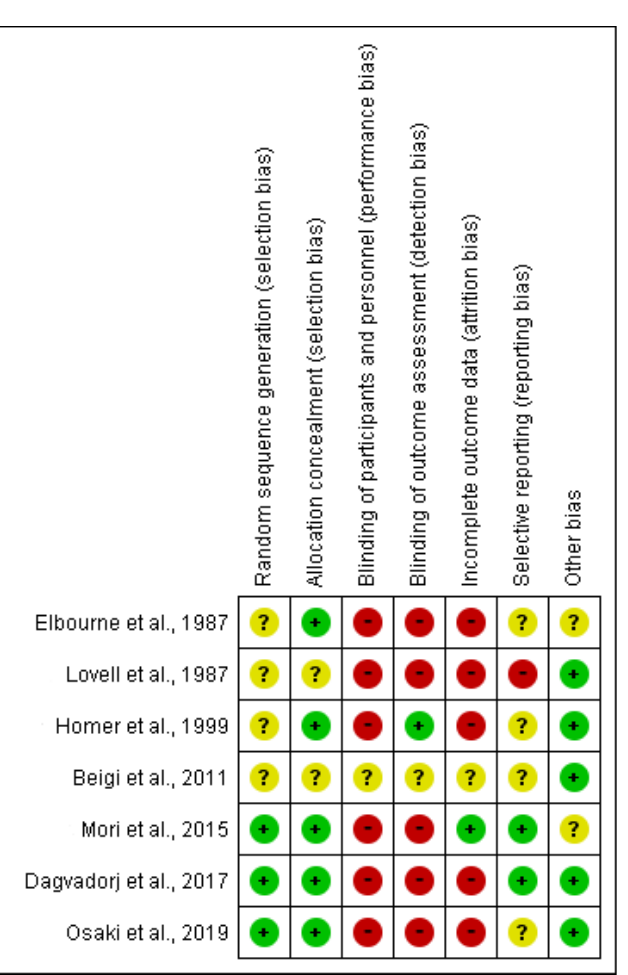
Figure 2. Risk of bias graph.